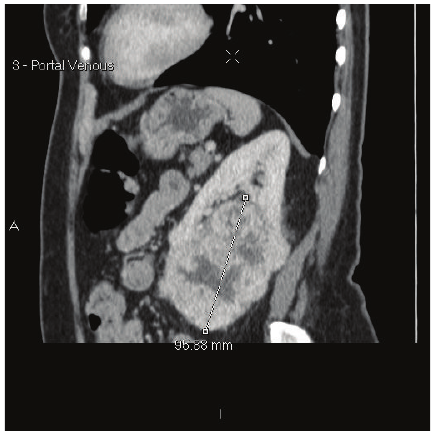
Figure 3: Sagittal portal venous phase staging CT scan demonstrat- ing a 96 mm left renal mass.